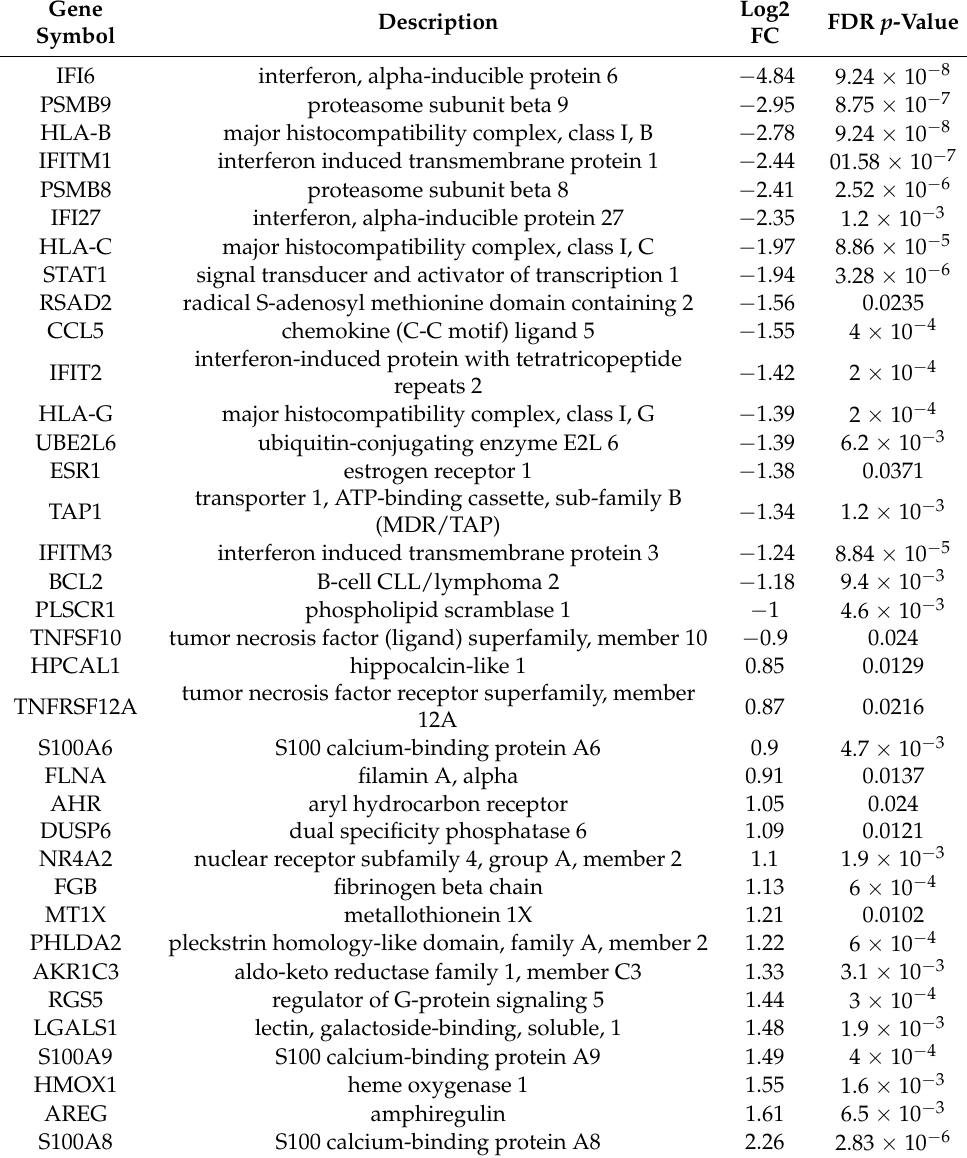
Table 5. List of apoptosis-associated genes regulated by miR193a-3p in